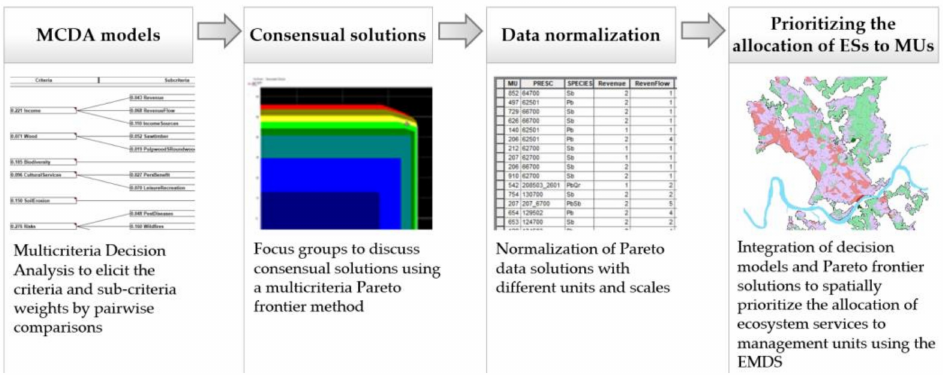
Figure 2. General steps of the methodological process and techniques